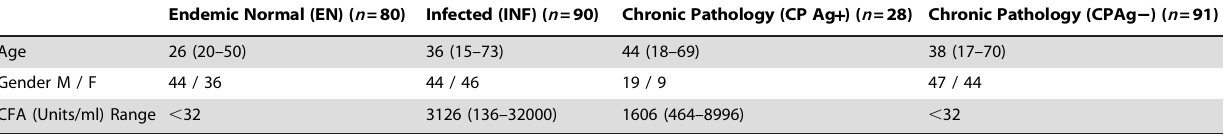
Table 1. Characteristics of the study